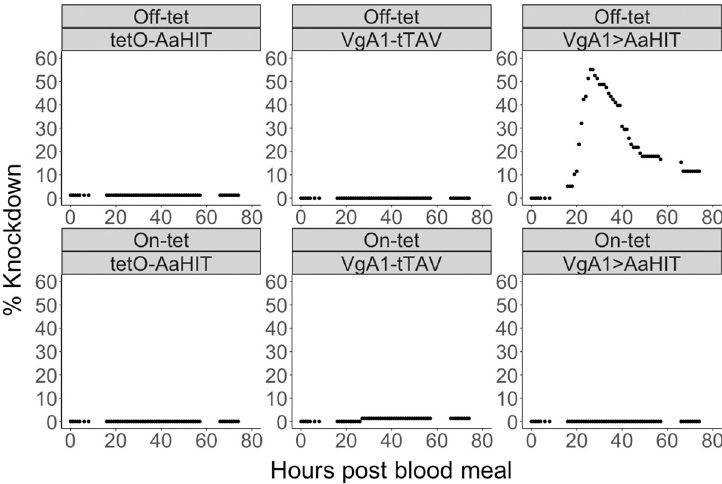
Fig 2. Repressible female knockdown phenotype in VgA1 > AaHIT. Graphs showing the percentage of females in a cage showing knockdown phenotype over time. Each panel represents a cage with the tet-status (off-tet or on-tet) and genotype (VgA1-tTAV, tetO-AaHIT and VgA1 > AaHIT) of females within that cage given in headers above each graph. Starting numbers of females in each cage were VgA1-tTAV off-tet (n = 104), tetO-AaHIT off-tet (n = 78), VgA1 > AaHIT off-tet (n = 78), VgA1-tTAV on-tet (n = 76), tetO-AaHIT on-tet (n = 87) and VgA1 > AaHIT on-tet (n = 88). Y-axis gives the net number (knocked down–recovered) of females in each cage which were knocked down at any given time point pbm (x-axis). In all cages, females had ceased to knockdown prior to any individuals recovering and as such the peak of each graph represents the total number knocked down in that cage. Knockdown response was largely isolated to the VgA1 > tTAV off-tet cage in a temporal pattern in keeping with known expression behaviour of the Aedes aegypti VitellogeninA1 gene. A large percentage of paralysed females (77%) recovered from this knockdown effect and went on to lay eggs (analysed in S1 Table).